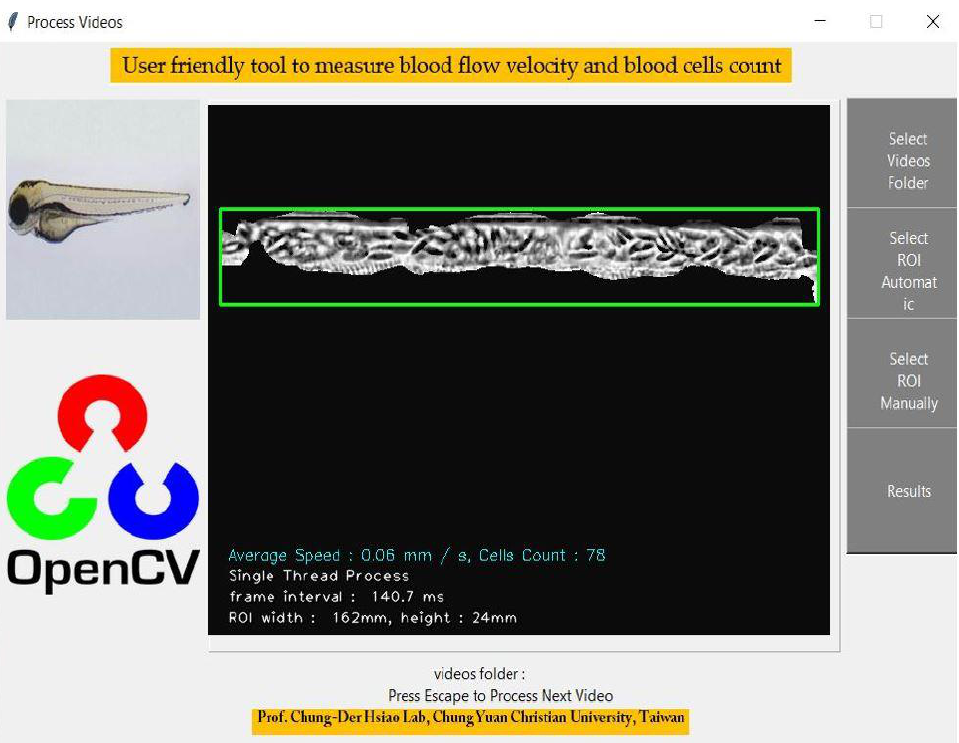
Figure 2. Simple graphical user interface of OpenBloodFlow GUI Package with complete functions for blood flow velocity and blood cell count analysis. OpenBloodFlow can automatically or manually select the blood vessel as dorsal aorta depending on video contrast and quality. We suggest using the manual function to determine specific ROI for blood cell count analysis for low contrast or poor videos quality.